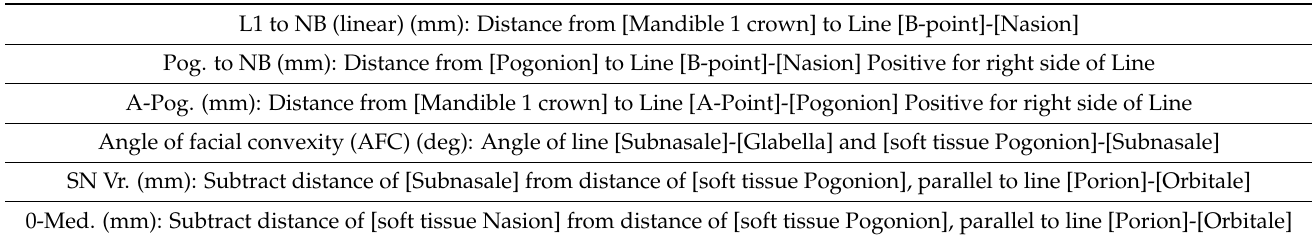
Figure 2. Orthognathic surgery patient with conventional fixed appliance. ( a ) Before surgery; ( b ) 2 days after surgery; ( c ) 6 months postoperative radiograph image. The bracket attached to teeth was not observed on radiographs. Table 1. Measurement variables.